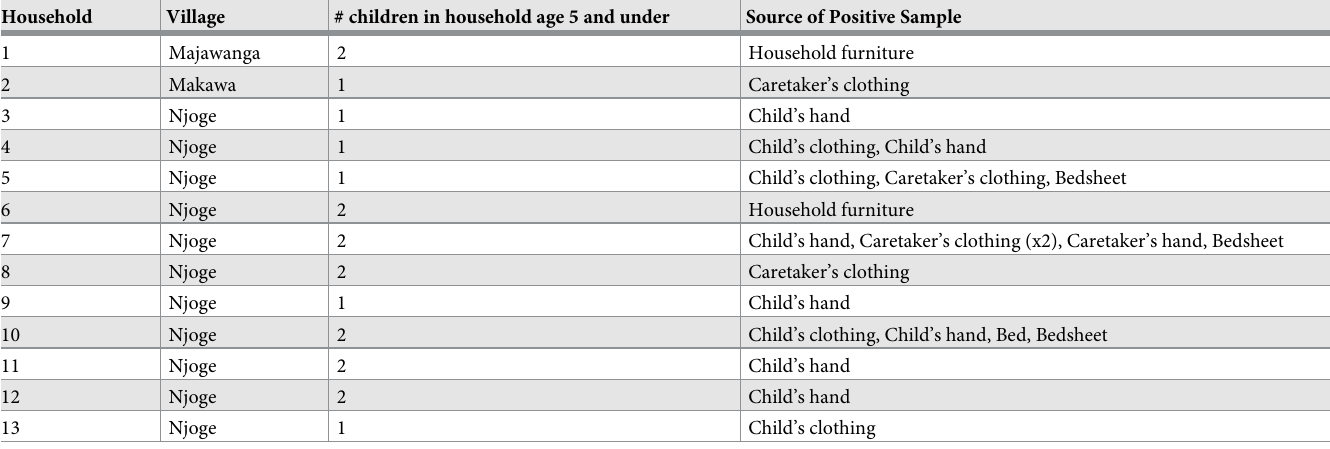
Fig 1. Environmental sources of PCR-positive environmental samples, over all samples taken for that source. https://doi.org/10.1371/journal.pntd.0007834.g001 The 23 positive environmental swabs were obtained from 13 households (Table 3). Twenty- one of the positive swabs, collected from 11 households, were from the same village, Njoge. The villages of Majawanga and Makawa each contributed one positive environmental sample and the remaining two villages yielded none. Obtaining at least one positive environmental swab from the household was associated with village of residence (ranging from 0% in Mkutani and Banyi Banyi to 34% in Njoge, p = 0.011) and presence of ocular infection in the index child (percent positive swabs 34% vs. 3%, p = 0.001) (Table 4). Although not statistically significant, a positive environmental swab was also associated with having an infant < 1 year of age in the house, households where secretions were wiped onto household furniture, those in which clothes had been washed � 3 days ago versus < 3 days ago, and those in which bed covers had been washed > 1 week ago versus < 1 Table 3. Description of 23 PCR-positive environmental